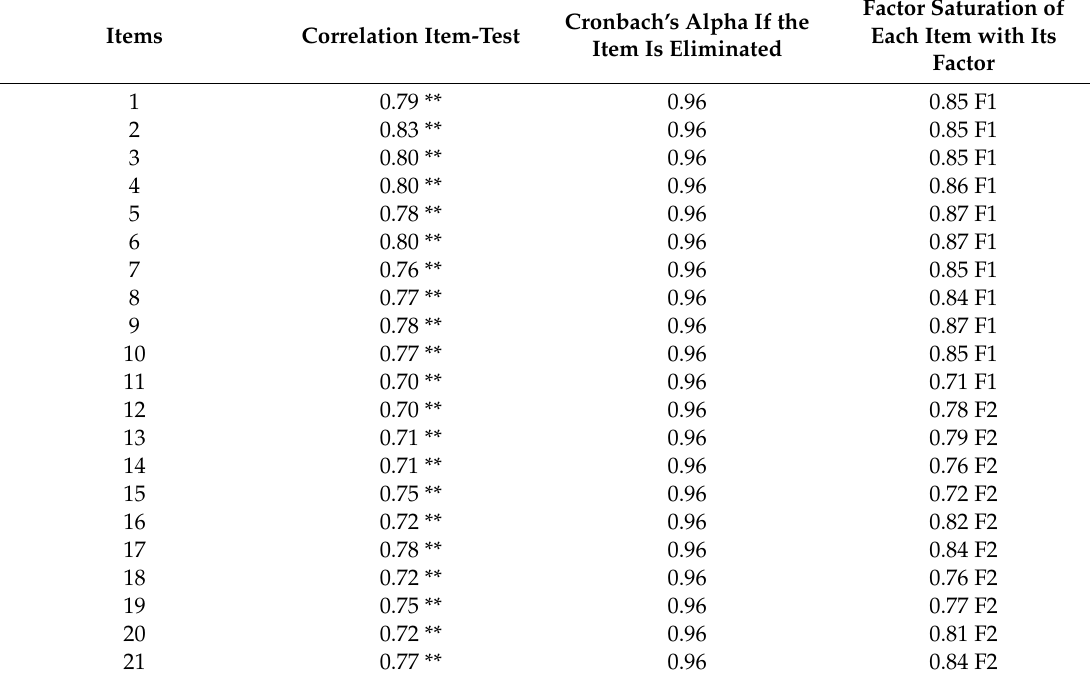
Table 2. Correlations between each item and the total score on